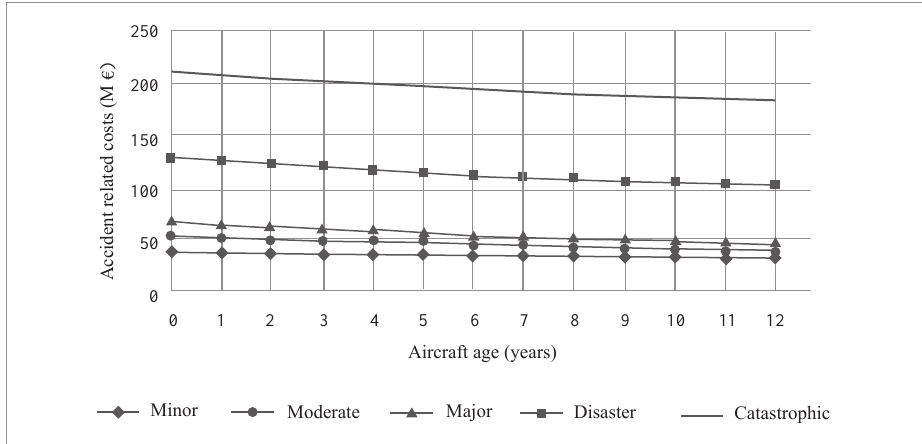
Fig. 3. Min total accident related costs as a function of aircraft age and accident severity (A320)